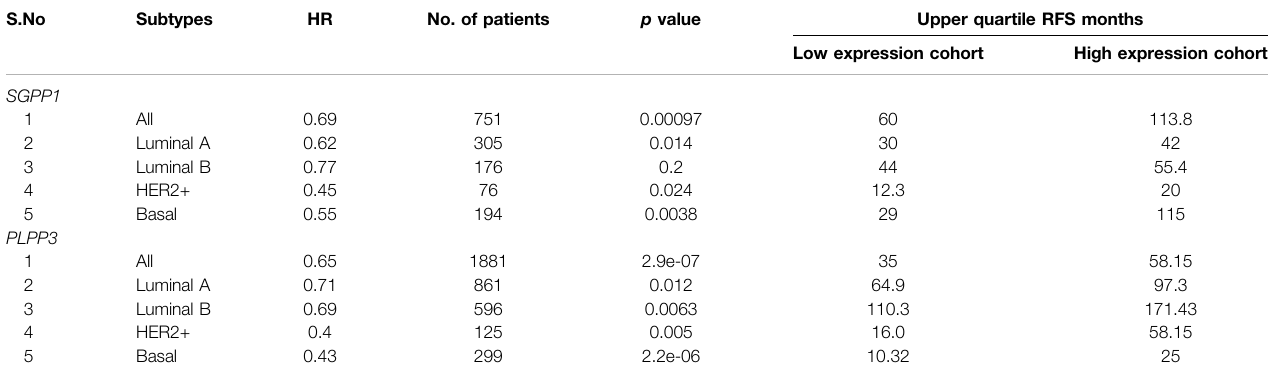
TABLE 4 | Correlation between mRNA expression of SGPP1 and PLPP3 with relapse-free survival (RFS) in the systemically treated in different breast cancer intrinsic subtypes.